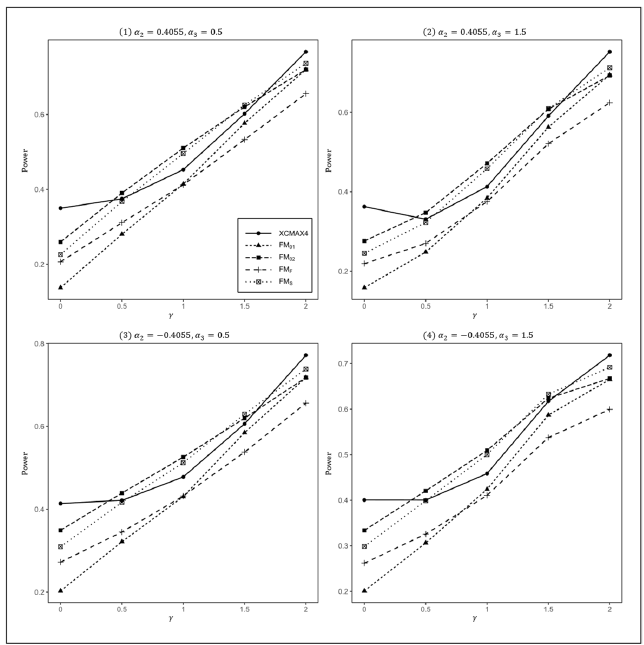
Figure 2. Estimated powers of XCMAX4, FM 01 , FM 02 , FM F , and FM S under various XCI models. The simulation was based on 10,000 replicates with β = 0.15, α 1 = − 5, F = 0, q f = 0.3, and q m = 0.2 .